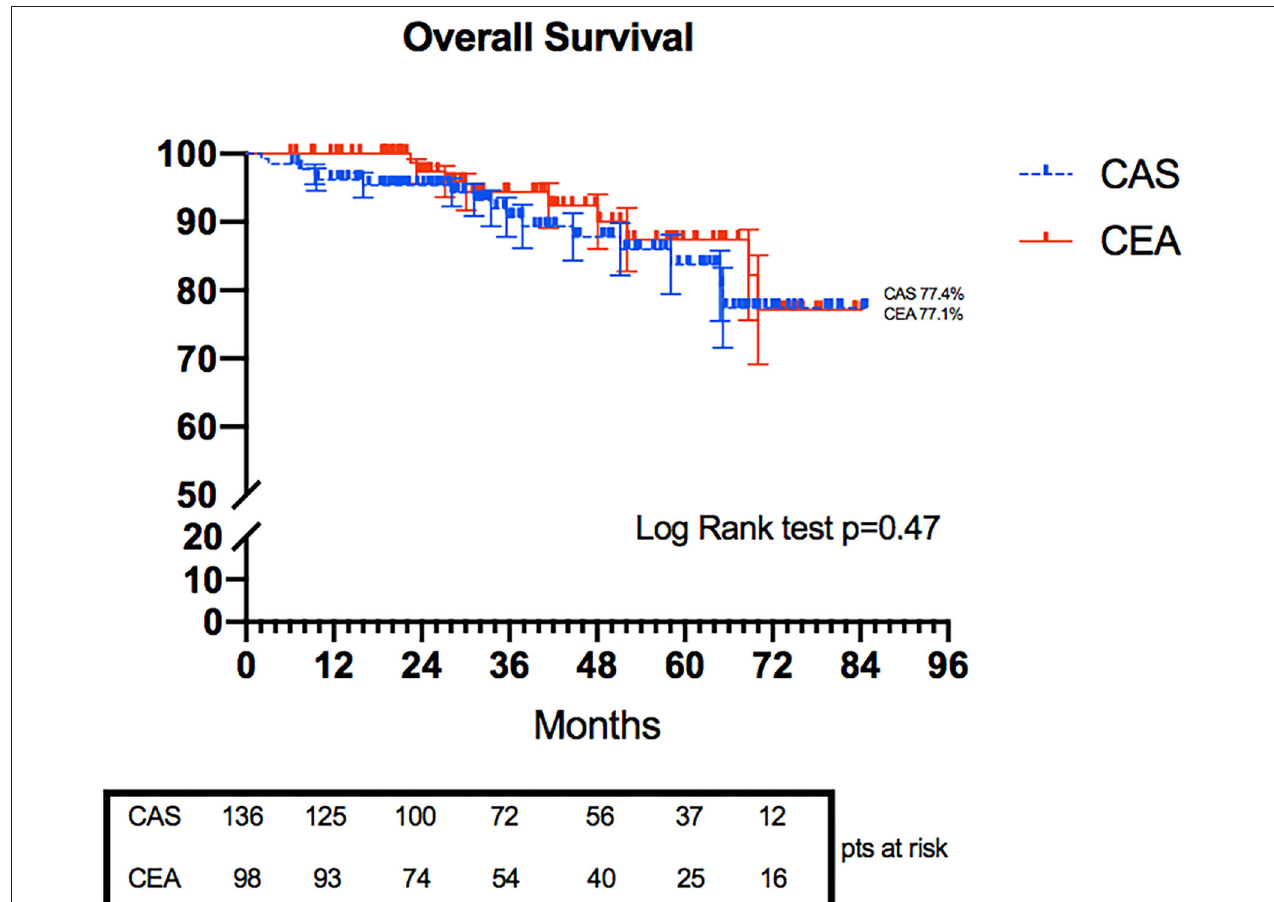
FIGURE 1 | Kaplan–Meier curves representing overall survival rates in CAS and CEA groups.